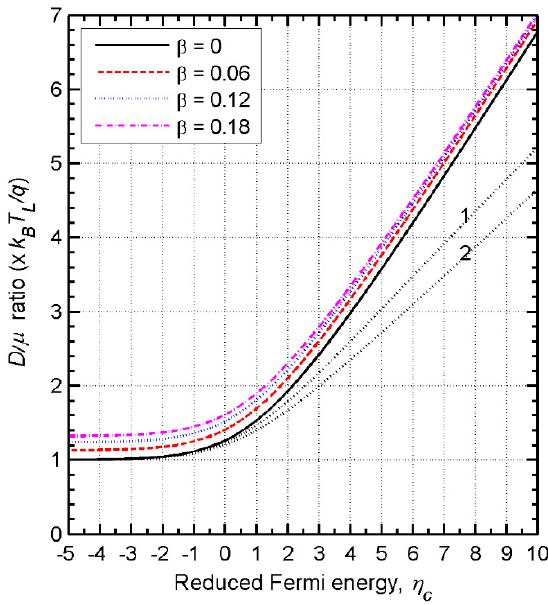
Figure 2. Calculated values of the D / μ ratios for electrons as a function of the reduced FE for selected various values of β . The dashed curve 1 displays the D / μ ratio calculated for electrons with the existing formula, Equation (6), for β = 0.06, and the dashed curve 2 for β = 0.18.